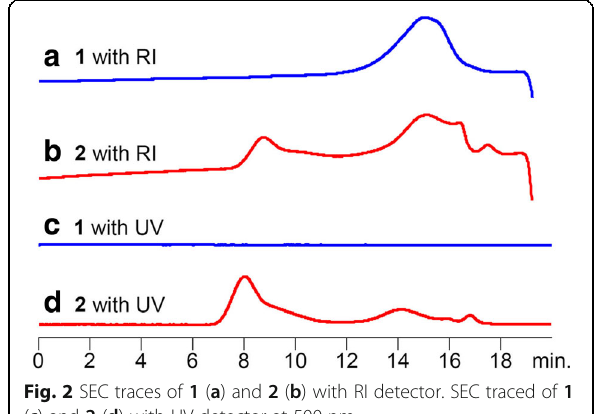
Fig. 2 SEC traces of 1 ( a ) and 2 ( b ) with RI detector. SEC traced of 1 ( c ) and 2 ( d ) with UV detector at 500